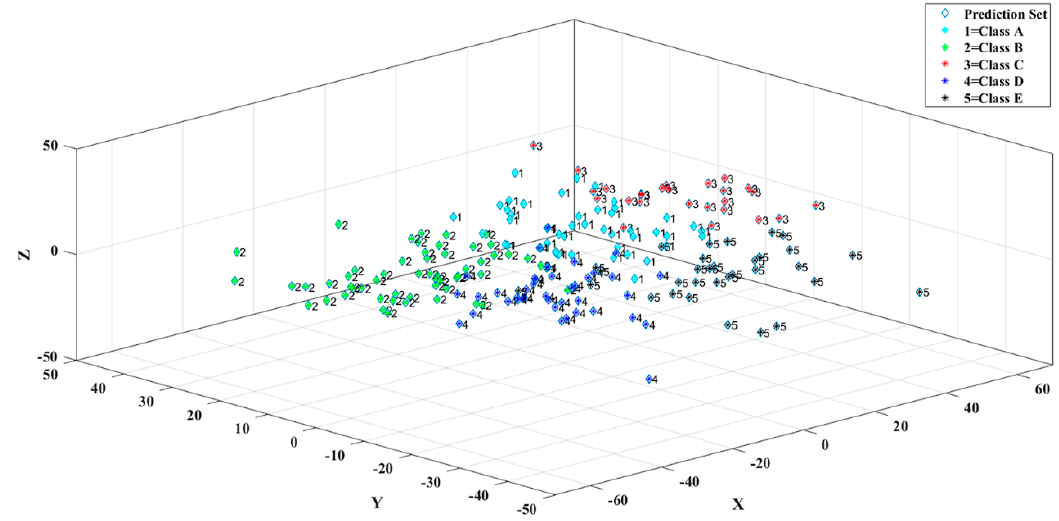
Figure 11. Discriminant analysis 3D-plot of PCA-GRNN model for predicted samples.